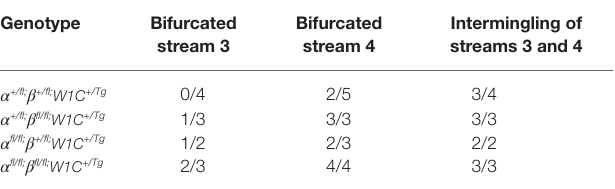
TABLE 3 | Bifurcation and intermingling of NCC streams entering PA3 and PA4 at E10.5.